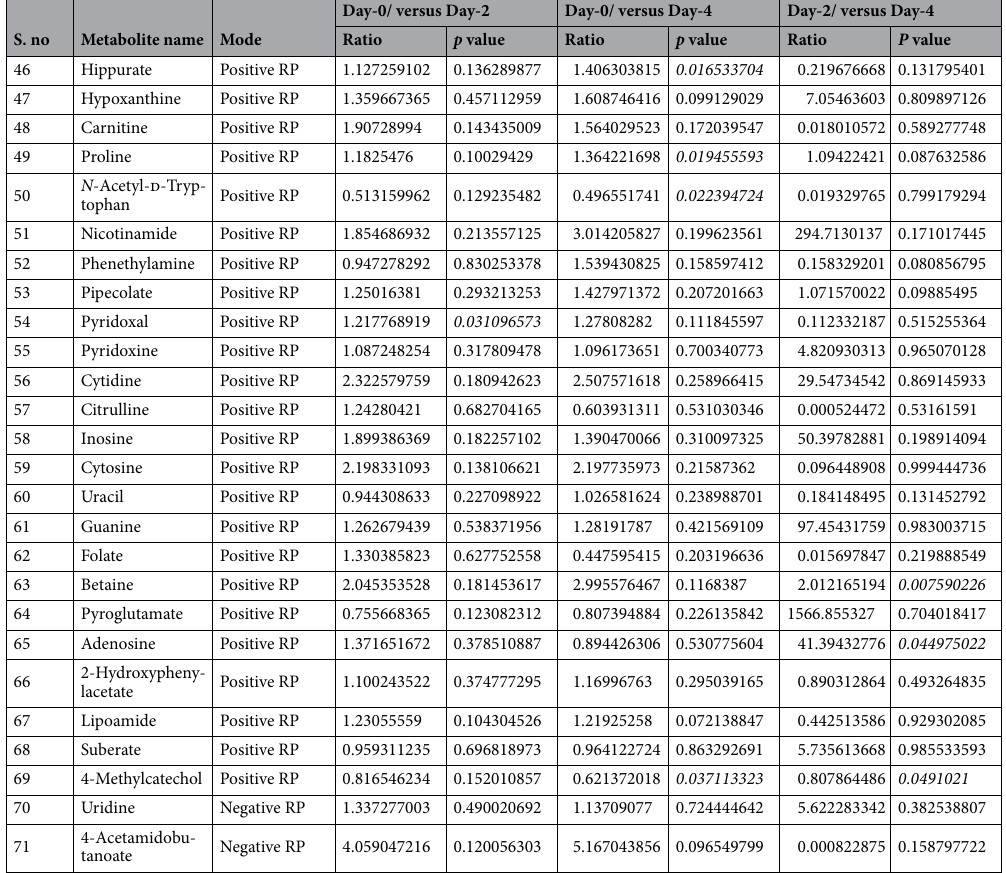
Table 1. Global and differential metabolite profiles during myogenic progression of primary human myoblasts. Italics values represent metabolites with significant values p <